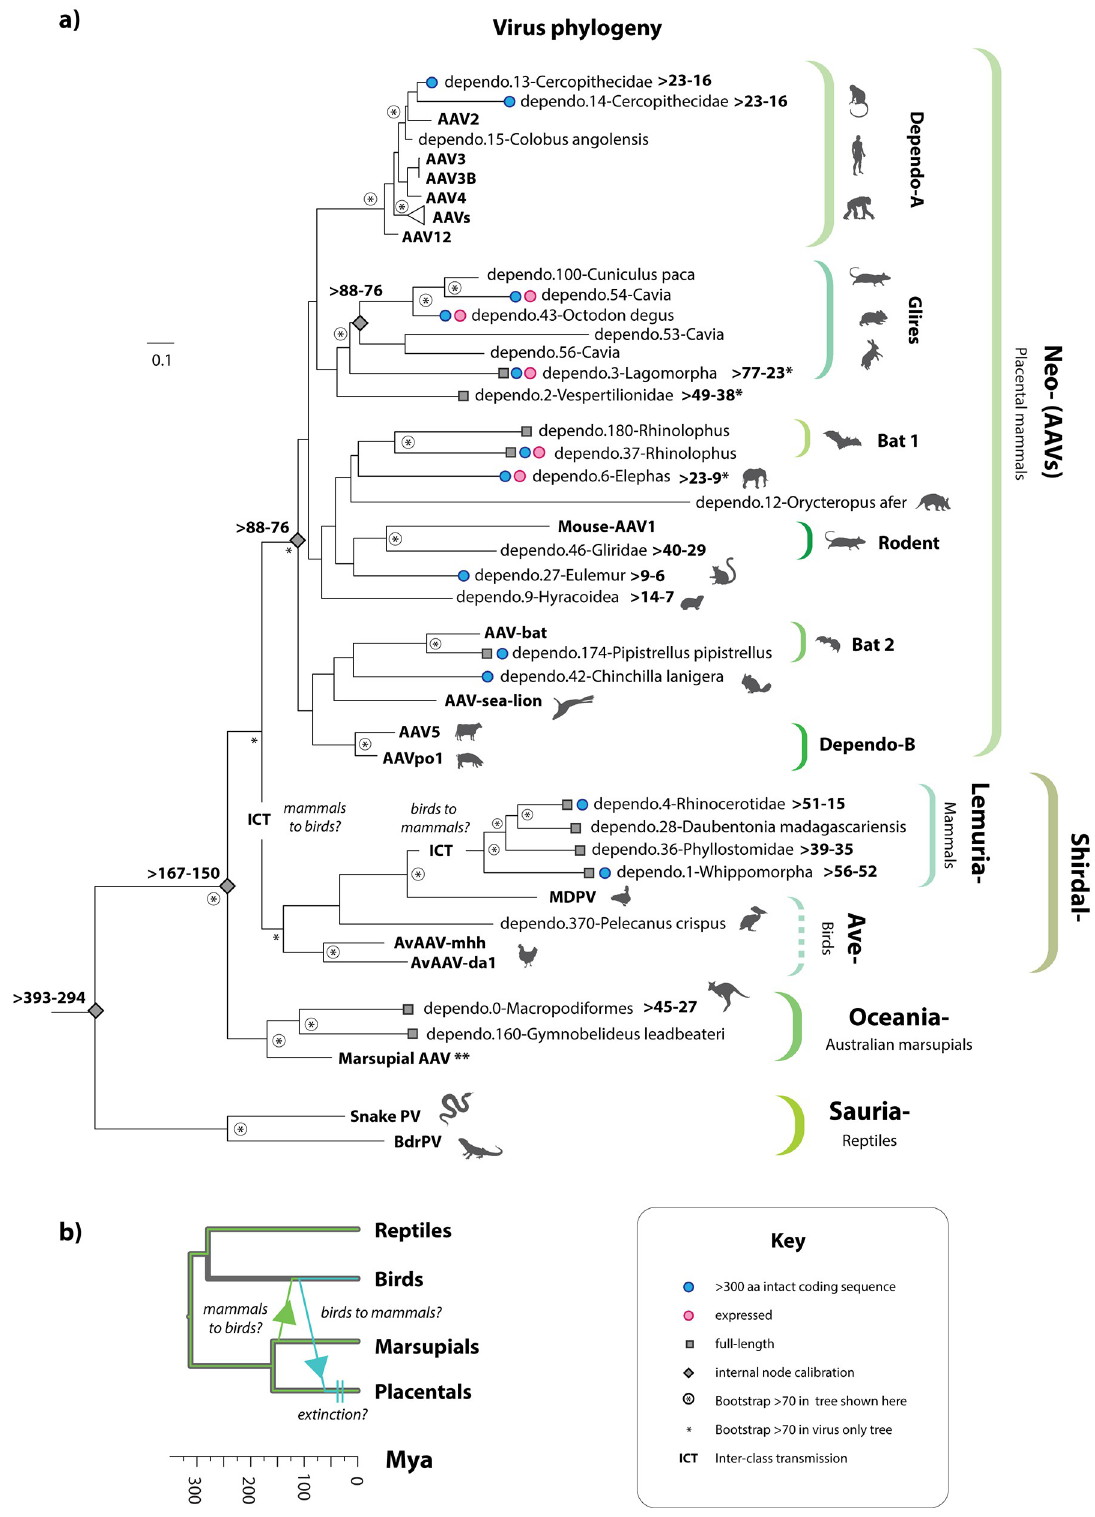
Fig 8. Dependoparvovirus evolution and the influence of interclass transmission. (a) An ML phylogeny showing the reconstructed evolutionary relationships between contemporary dependoparvovirus species and the ancient dependoparvovirus species represented